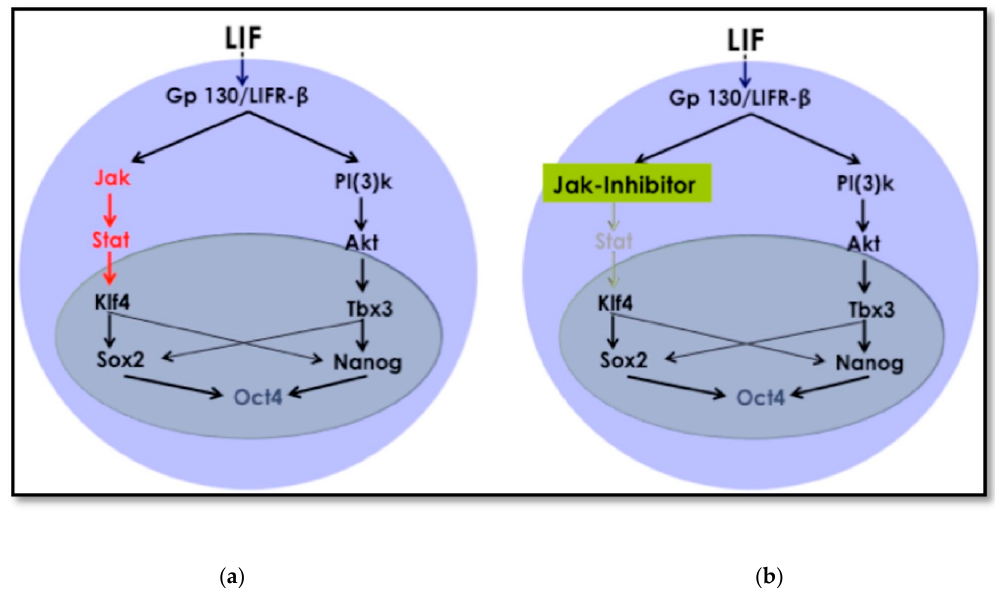
Figure 8. Schematics of the LIF/JAK-STAT3 pathway active and blocked by a JAK inhibitor. ( a ) LIF binds to its Gp130/LIFR- β and activates the JAK-STAT3 pathway. Its activation leads to the direct stimulation of the pluripotency circuitry transcription factors in the nucleus for pluripotency reprogramming. ( b ) When JAK-STAT and no other pathway is inactivated, the stimulation of the pluripotency circuitry decays, and the reprogramming process is affected.